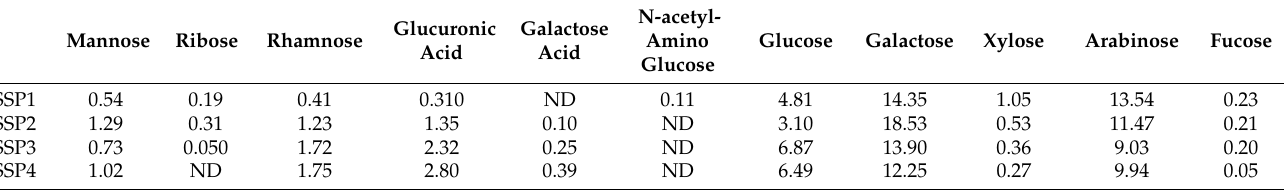
Table 3. Monosaccharide composition of